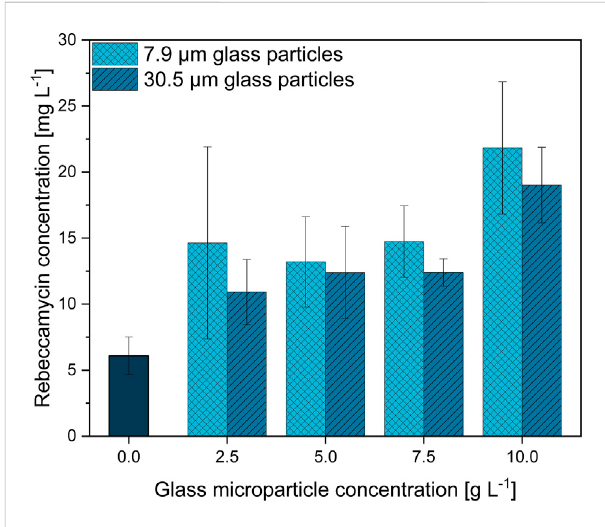
FIGURE 3 Rebeccamycin concentration of 10-day L. aerocolonigenes cultivation without microparticle addition (control) compared to MPEC with glass microparticle addition (x 50 = 7.9 or 30.5 µm) in varying concentrations in the range of 2.5 – 10 g · L − 1